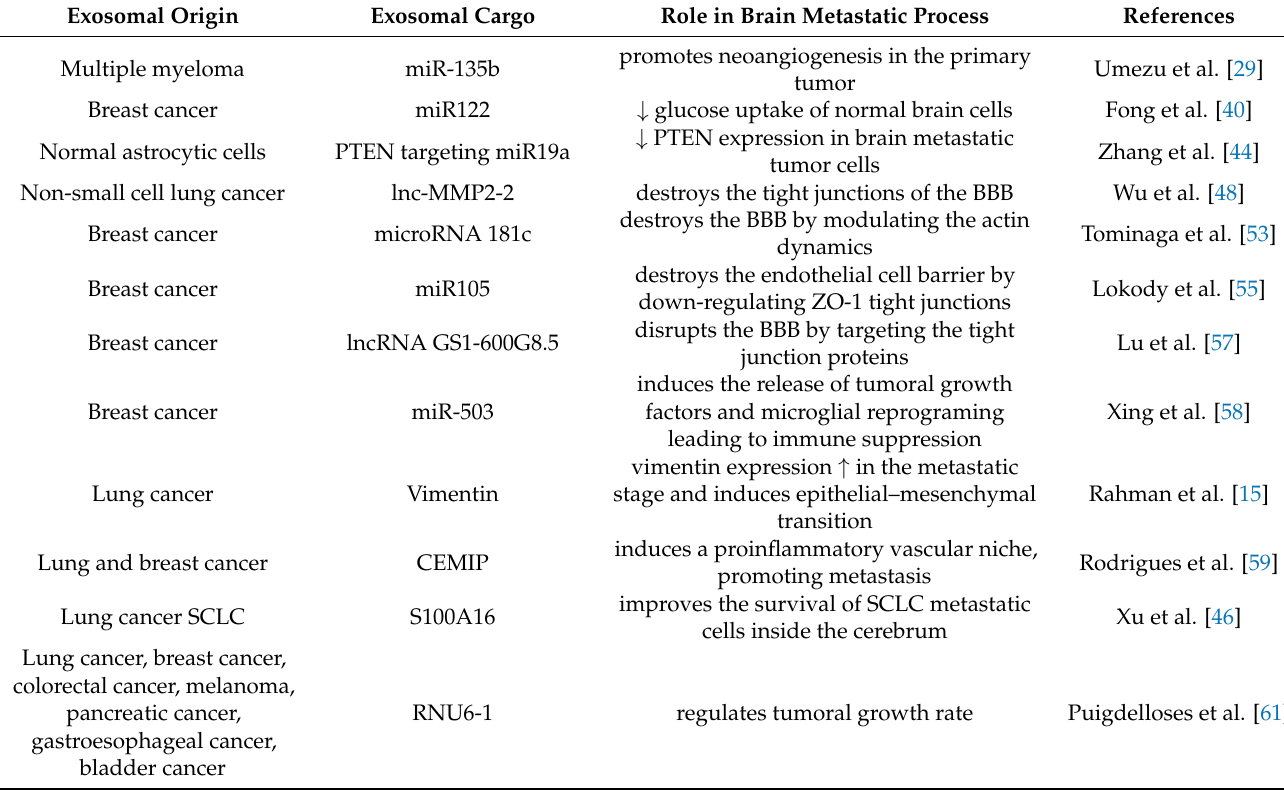
Table 1. The importance of the exosomal cargo in the brain metastatic